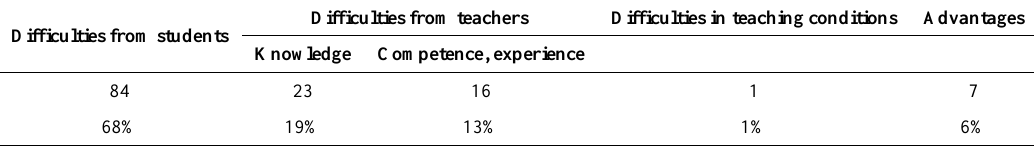
Table 7. Advantages and difficulties when using idioms and proverbs